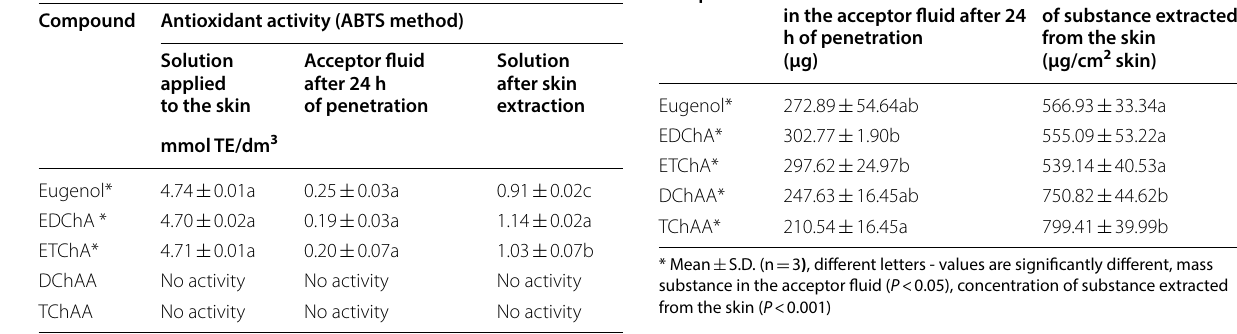
Table 3 Antioxidant activity of 1% solutions of the test compounds applied to the skin, acceptor fluid obtained after 24 h of collection, and solutions obtained after skin extraction Compound Antioxidant activity (ABTS method)